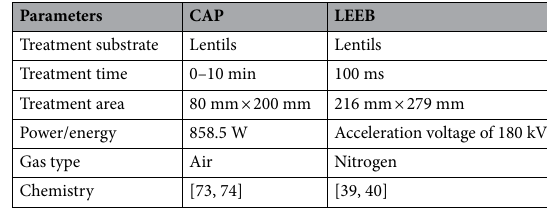
Table 2. Comparison of cold atmospheric pressure plasma (CAP) and low energy electron beam (LEEB) parameters used for treatment of lentil seeds in this study.